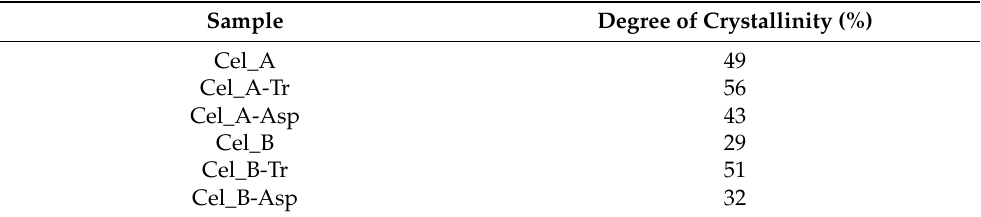
Table 3. The results of the X-ray diffraction pattern of native celluloses and celluloses hydrolyzed with